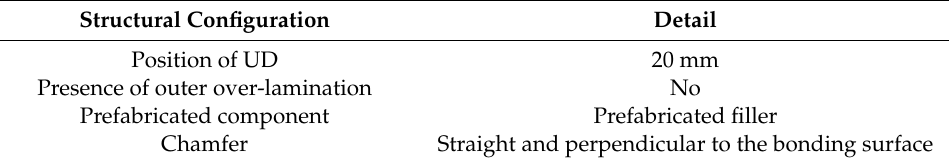
Table 4. Structural configurations of the benchmark model.